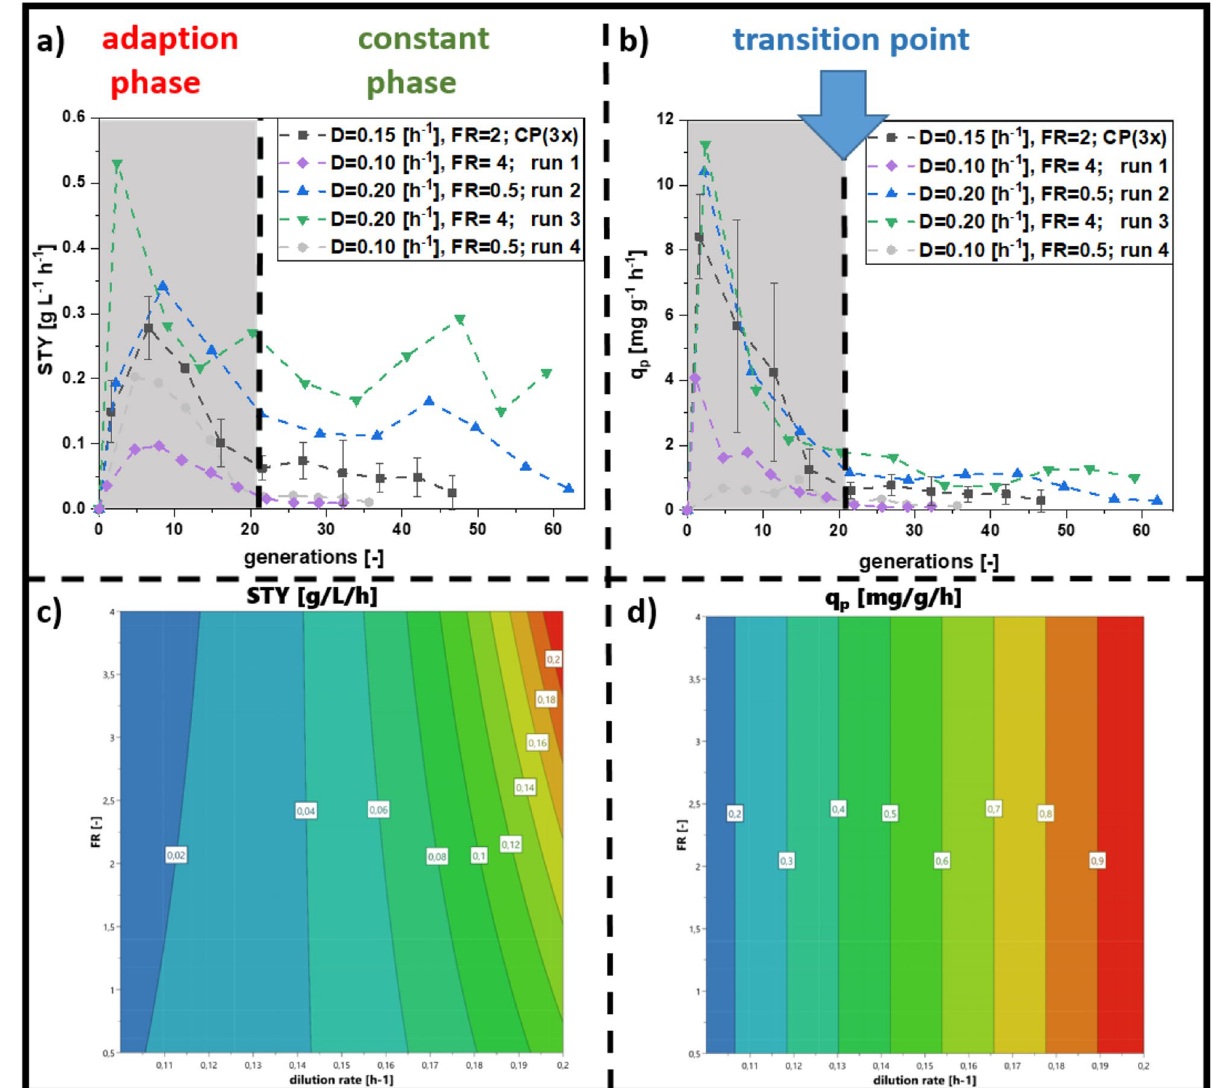
Figure 2. Results derived from the multivariate experiments carried out for cascaded continuous cultivation for the N-pro protein. Centerpoint runs (CP) were summed up in a trend line (triplicate). ( a ) Space–time-yield (STY), ( b ) specific productivity (q p ), contour plot for ( c ) STY and ( d ) for q p . High dilution rates, as well as a high uptake rates of glycerol and low rates of lactose seem to be preferable to achieve a high specific productivity and a high STY ( FR feed ratio, D dilution